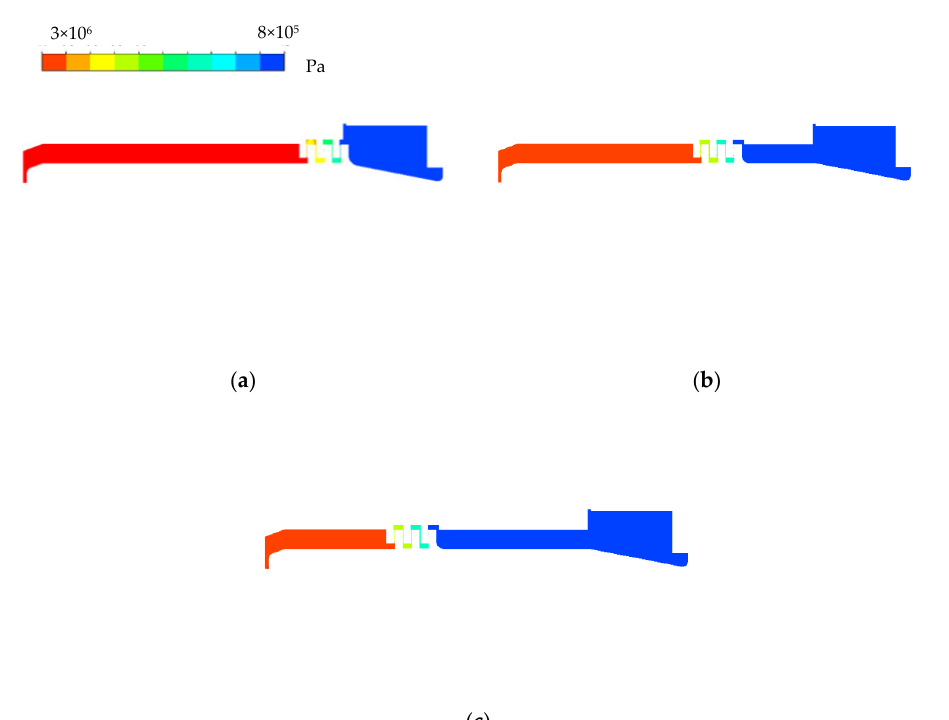
Figure 8. Pressure distribution diagrams of upper crown clearance. ( a ) UC + 0. ( b ) UC + 300. ( c ) UC + 600.